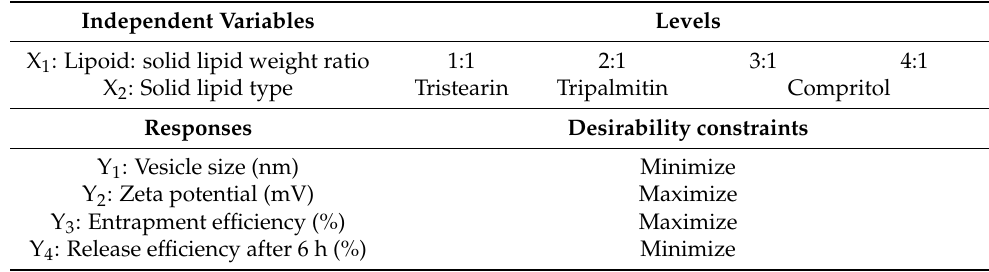
Table 1. Variables’ levels and responses’ desirability constraints applied in a 4 1 3 1 factorial design.